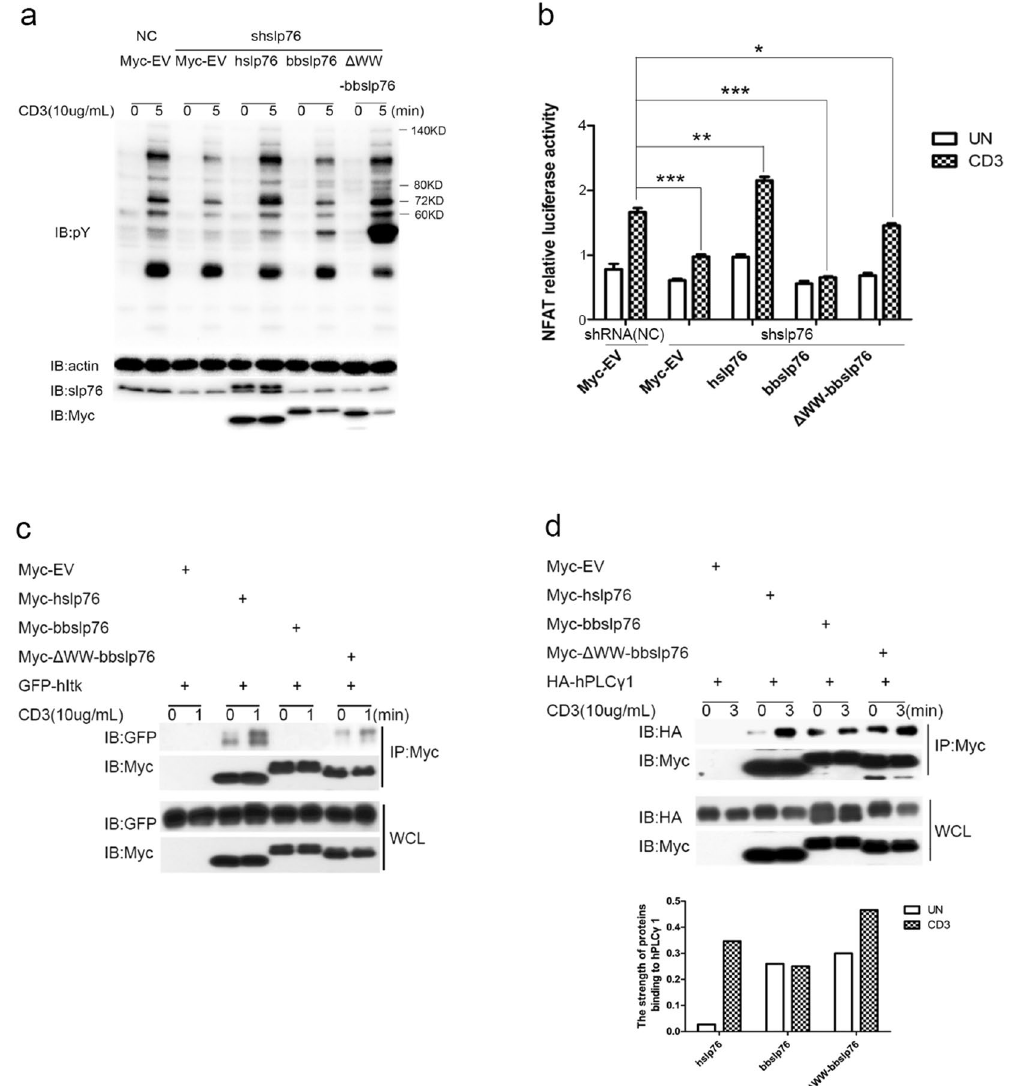
Figure 6. Δ WW-bbslp76 rescues total tyrosine phosphorylation but partially rescues NFAT activation after TCR ligation in T cells. ( a ) Δ WW-bbslp76 rescued total tyrosine phosphorylation in T cells. Jurkat TAg cells were transfected with the indicated constructs and cells and lysates were prepared as in Fig. 3(a). ( b ) bbslp76 partially rescued NFAT activity in T cells. Jurkat TAg cells were transfected with NC and shslp76. NC and shslp76 cells were transfected with an NFAT reporter construct and a co-transfected Renilla luciferase and the indicated constructs. 48 hrs later, cells were untreated or stimulated with CD3 (3 μ g/mL) for 8 hrs and lysed for reporter gene assay. Luciferase activity was normalized using a co-transfected Renilla luciferase. The data represent the mean ± SD from triplicate determinations. * P < 0.05, ** P < 0.005, *** P < 0.0005. ( c ) Δ WW-bbslp76 interacts with hItk. Jurkat TAg cells were transfected with the indicated constructs. After 48 hrs, cells were stimulated with or without CD3 (10 μ g/mL, 3 min) and then lysed; lysates were split into two parts, one part of the lysates was subjected to a Myc IP, and the other part was used for WCL (40 μ L). Samples were studied by western blot, and probed with indicated antibodies. ( d ) Δ WW-bbslp76 interacts with hPLC γ 1. Jurkat TAg cells were transfected with the indicated constructs. After 48 hrs, cells were stimulated with or without CD3 (10 μ g/mL, 1 min). Cells and lysates were prepared as in ( c ). Samples were studied by western blot, and probed with the indicated antibodies. The binding affinity is normalized by IB HA to IP Myc. The experiments were repeated three times with very similar results. The strength of protein-protein interaction was analyzed by software Quantity